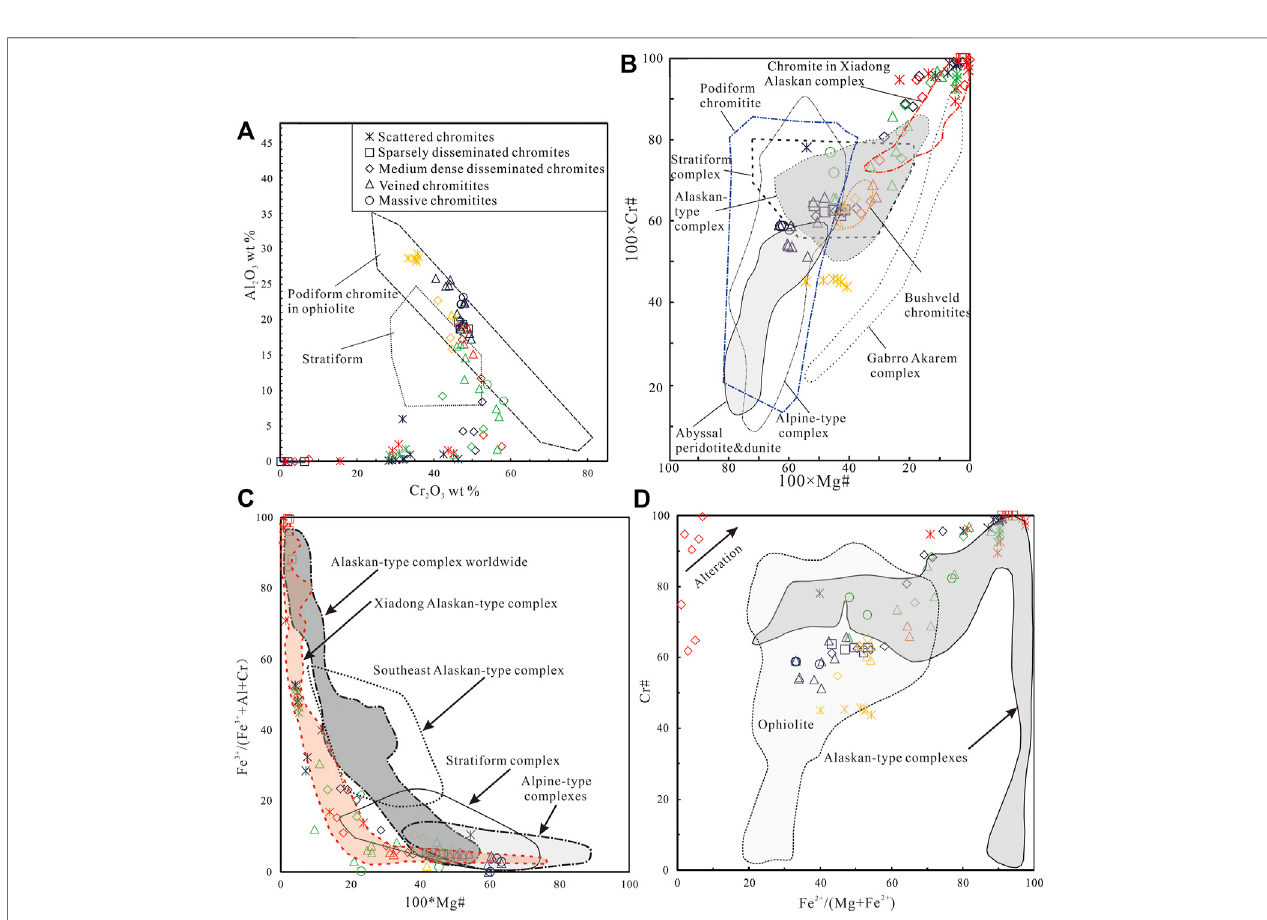
FIGURE 9 | Chromite compositional comparisons of the Hongshishan complex with abyssal peridotites, ophiolites, Alpine-type complex, Bushveld chromites, stratiform complex, and typical Alaskan-type complexes. (A) Plot of Al 2 O 3 vs. Cr 2 O 3 of chromites. Compositional fi elds of podiform and stratiform chromites are from Bonavia et al. (1993); (B) Cr# vs. Mg# diagram of chromites. Compositional fi elds of abyssal peridotites and dunites are from (Dick and Bullen, 1984); the fi elds of podiform,stratiform,Alaskan-typecomplex,BushveldchromitesandAlpine-type fi eldarefromIrvine(1967)andLeblancandNicolas(1992);the fi eldoftheGabbro Akarem complexesisfromHelmyandElMahallawi(2003);the fi eldoftheXiadongAlaskancomplexisfromSuetal.(2012); (C) PlotofMg#versusFe 3+ / (Fe 3+ +Al+Cr)of chromites. The fi eld of Alaskan-type complexes worldwide is from Barnes and Roeder (2001); Southeast Alaskan-type complexes, stratiform complexes, and Alpine- type complexes are from Irvine (1967); the Xiadong fi eld is from Su et al. (2012); (D) Plot of Fe 2+ / (Mg + Fe 2+ ) vs. Cr# of chromites. The fi elds of Alaskan-type complexes and ophiolite and alteration trend are after Barnes and Roeder (2001). Different symbol colors correspond to different degrees of magnetization or ferritchromite levels.